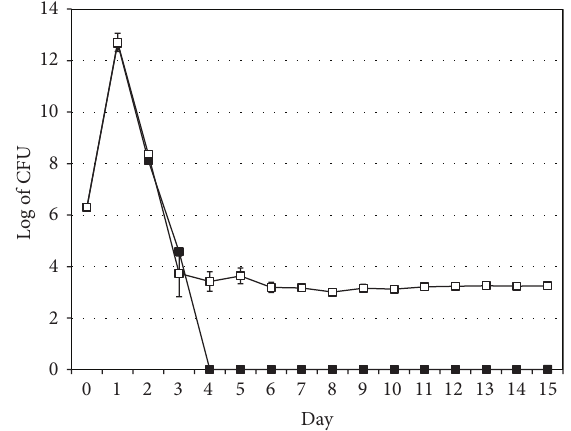
Figure 2: Growth and survival of wild-type V. cholerae (filled squares) and the OmpA mutant strain (empty squares) cultivated alone. Data represent mean ± SD from three different experiments.